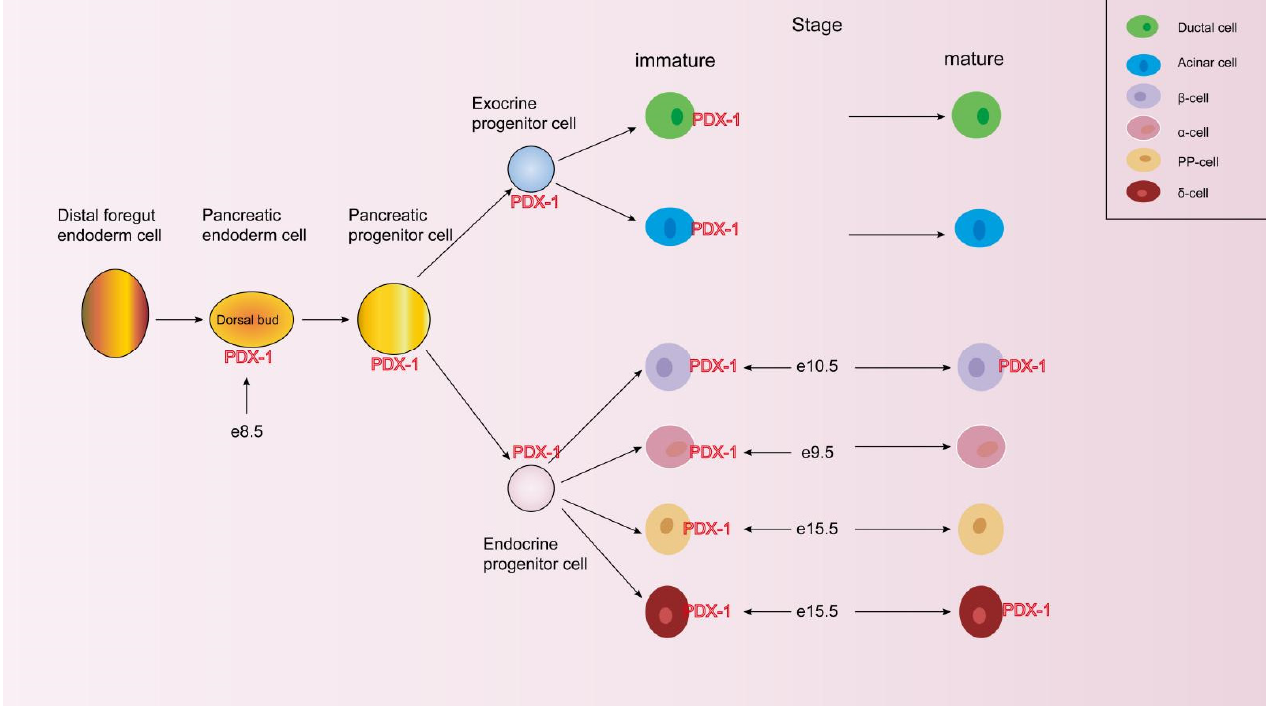
Figure 3. Schematic representation of the PDX-1 involved in the development of the pancreas and the differentiation of islet cells. During embryogenesis, the pancreas arises from the foregut of the endoderm in the area that will become the duodenum. PDX-1 is essential for pancreatic development and β -cell differentiation. It is expressed in both endocrine cells and exocrine cells before maturation and is first detected in the gut’s dorsal region at embryonic days (e8.5). At e9.5, its expression is localized to the dorsal and ventral buds concomitantly with the first glucagon-secreting α cells. At e10.5, insulin-producing β -cell appear, and PDX-1 is a marker of β -cell formation and maturation. At e15.5, PDX-1 specifically expressed in δ cells and PP cells. With the development of the pancreas, PDX-1 is only specifically distributed in β cells and δ cells.